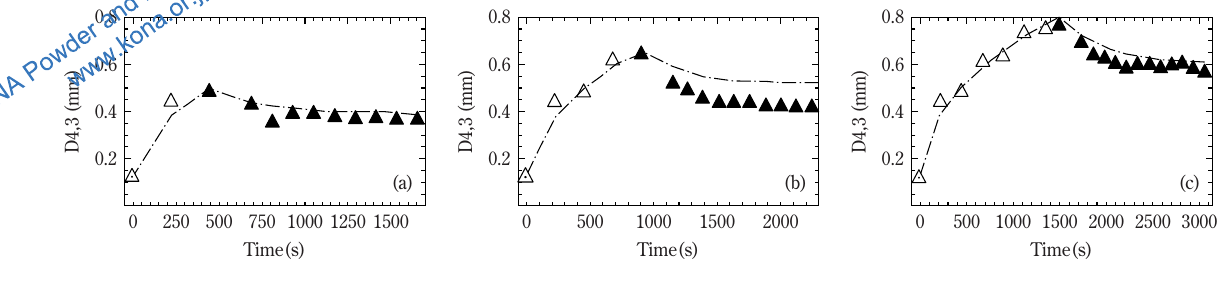
Fig. 7 Comparison between model and experimental results for the change in mean size for liquid-to-solid ratios of (a) 0.05 (b), 0.1, and (c) 0.2 in fluidised bed granulation